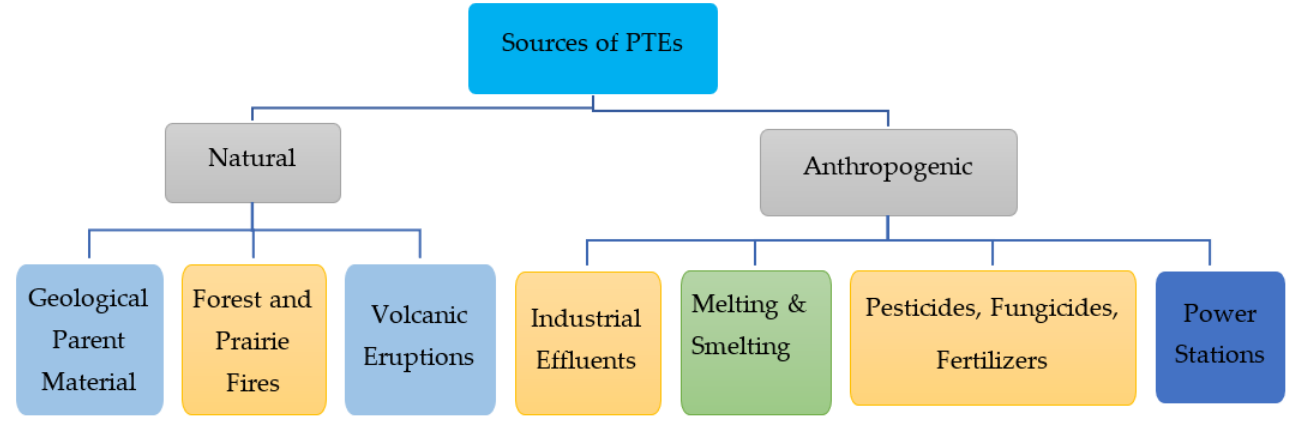
Figure 1. Different natural and anthropogenic sources of heavy metals or PTEs in the